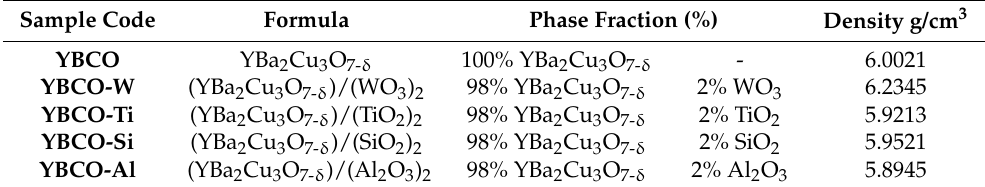
Table 1. The labels, the phase portion, and the chemical formula of each prepared ceramic. Sample